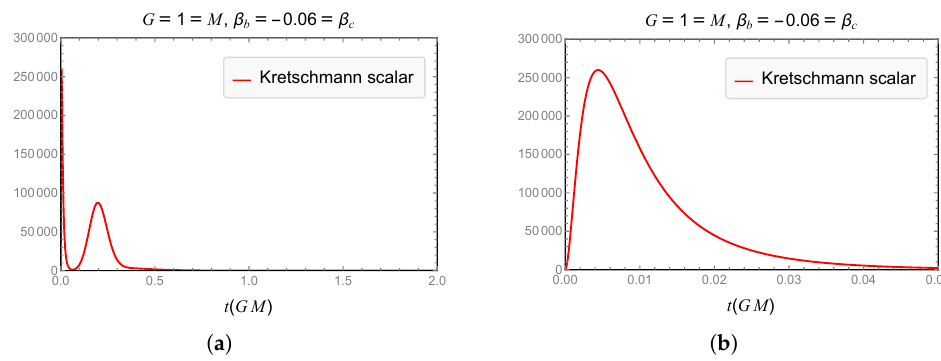
Figure 18. K in GUP model 1. ( a ) The Kretschmann scalar K for model 1 as a function of the Schwarzschild time t . ( b ) Close up of K close to t = 0. It is seen that K remains finite everywhere in the interior and vanishes for t =